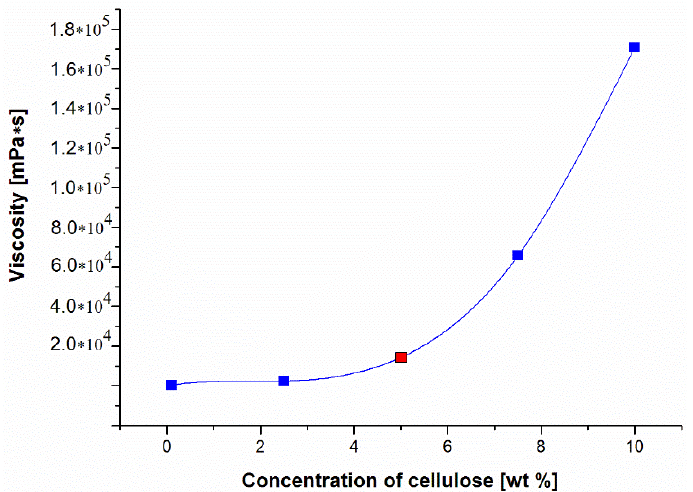
Figure 1. The results of viscosity tests of cellulose solutions in 1-ethyl-3-methylimidazolium acetate (EMIMAc) (measurement temperature 25 ◦